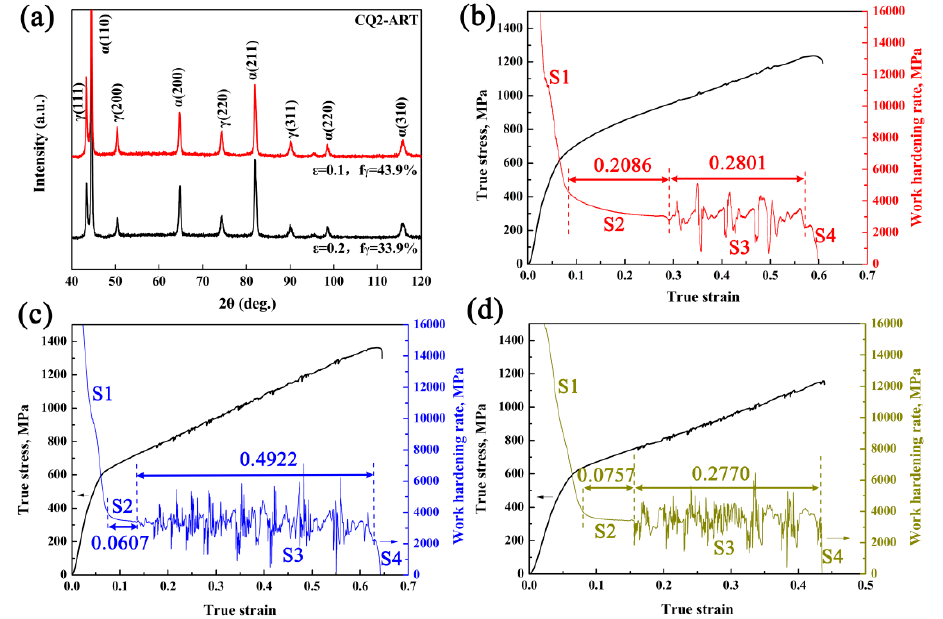
Figure 6. ( a ) XRD pattern of CQ2-ART sample at different engineering strains, work hardening rate and true stress–strain curves of the cyclic quenching samples: ( b ) CQ1-ART, ( c ) CQ2-ART, ( d ) CQ1-ART.